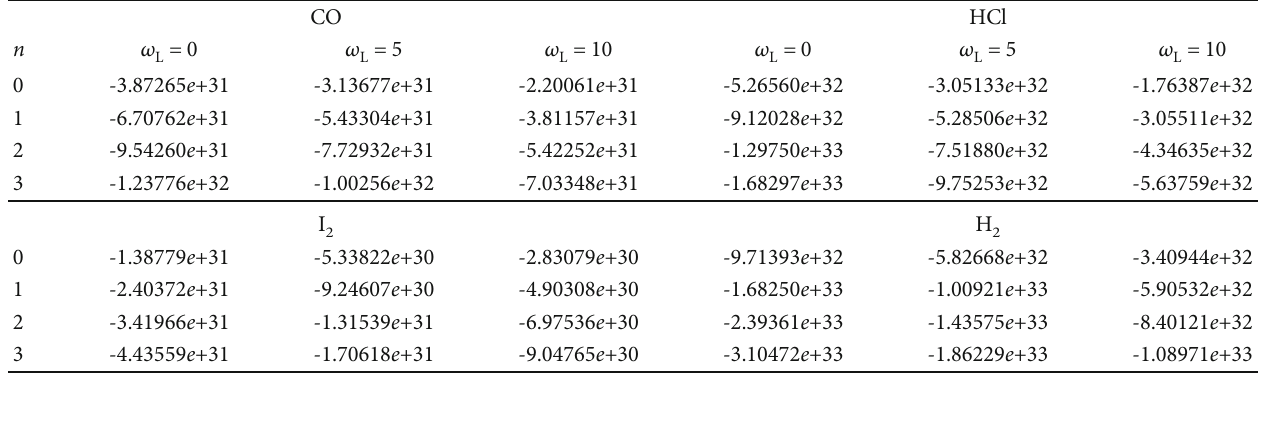
, and H molecules bounded by the isotropic oscillator plus inverse quadratic 2 2 with g = m = z = e = 1 L